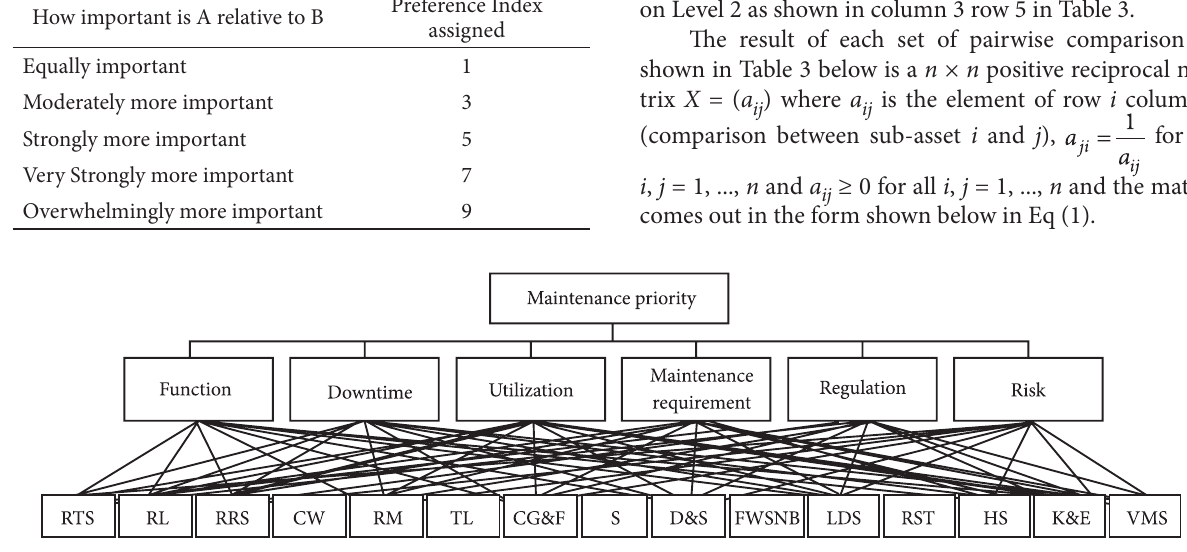
Fig. 2. Decomposition of UK Trunk road network assets